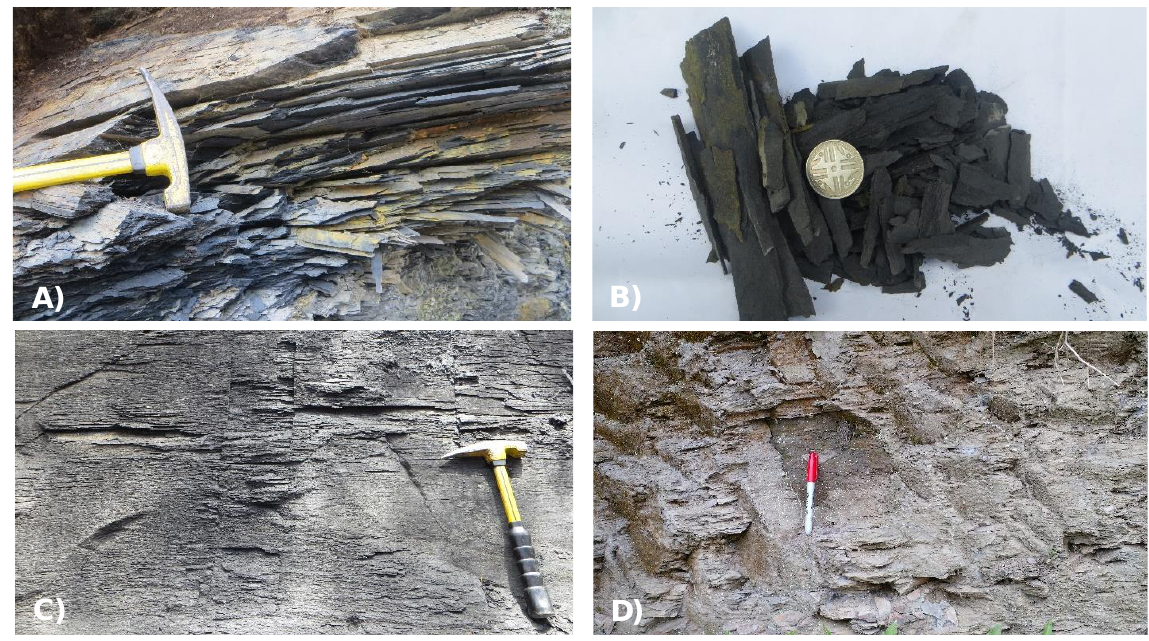
Figure 2. Outcrops and samples of mudstones in the Kip Unit, highlighting their structure, composi- tion, and various colors (shades). ( A ) Straw strips or structures measuring 15 × 2 cm 2 colored by weathering and its bituminous components ( B ), darker in color and smelling of sulfur; coin diameter 24.4 mm) on a slope in the San Luis neighborhood. ( C ) Massive to incipiently laminated rock with joints (vertical, closed); ( D ) observed in thick stratification and with discontinuous lamination, plane- parallel, in the outcrop of Palmira neighborhood, whose liliaceous color is due to the high content of pyrophyllite. Marker length = 12.5